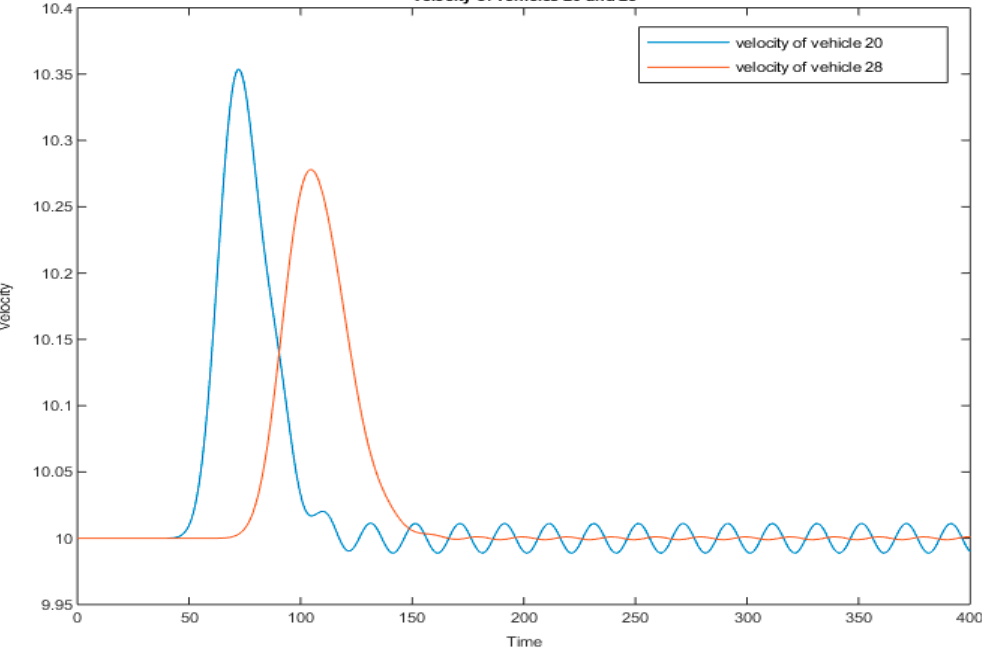
Figure 8. Time at which the harmonic disturbance imparted to the leader reaches each vehicle, on ( top ), and peak velocity, on the ( bottom ), versus the vehicle number.